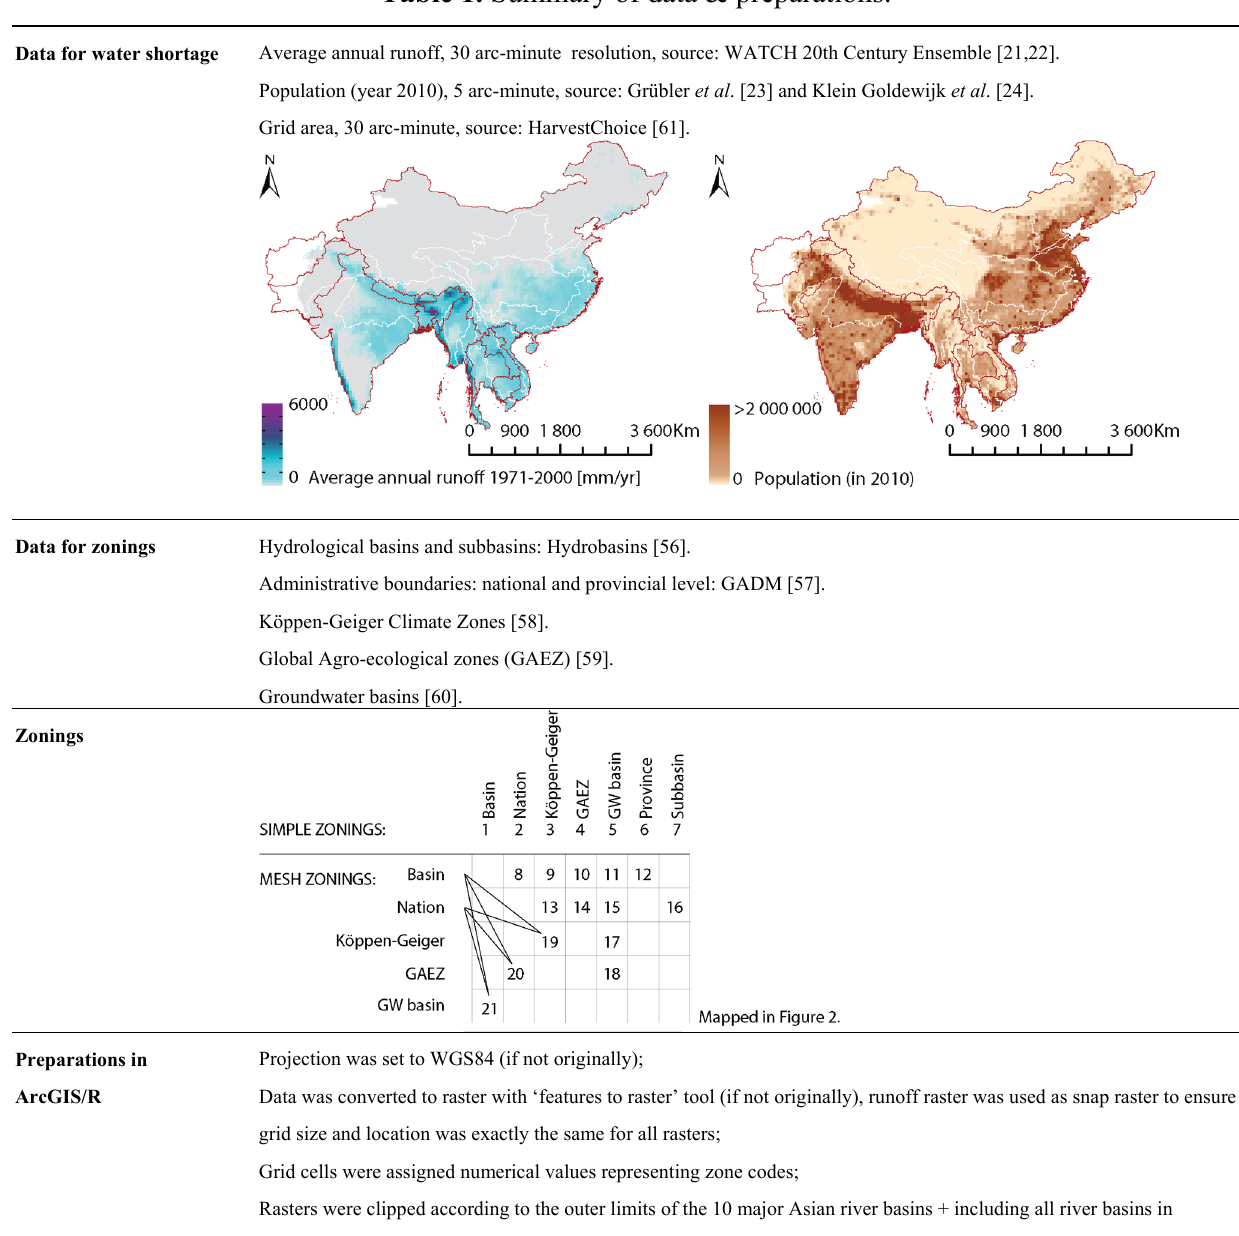
Table 1. Summary of data &